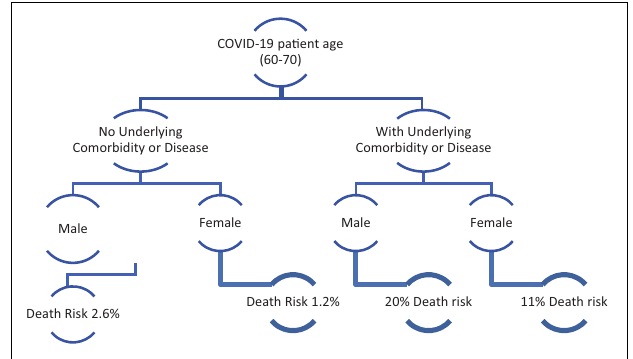
FIGURE 2 | Decision tree example for the classifications of patients with COVID-19 into two classes (Gonçalves and Rouco, 2020).